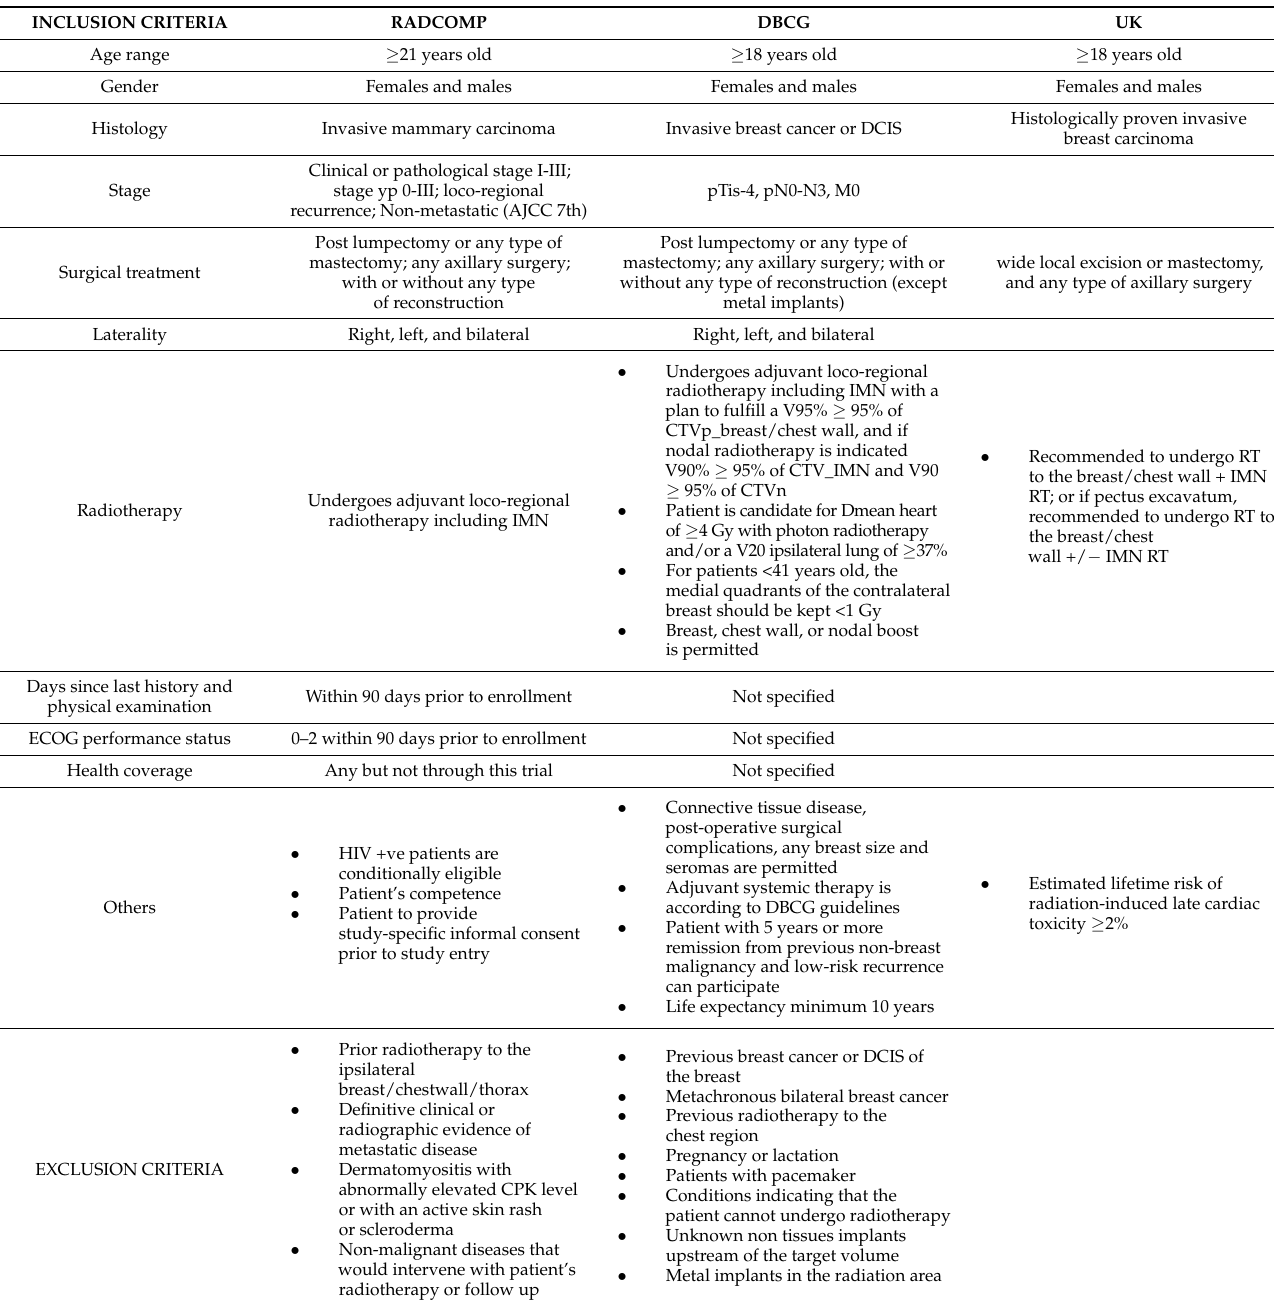
Table 2. A comparison of eligibility criteria between the Pragmatic Randomized Trial of Proton versus Photon Therapy for Patients With Non-Metastatic Breast Cancer (RADCOMP), The Danish Breast Cancer Group phase 3 Randomized Breast Cancer Trial (DBCG) and the UK ISRCTN14220944